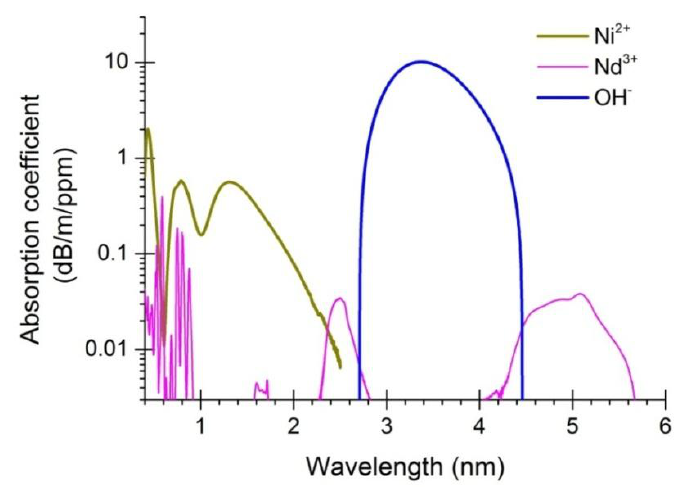
Figure 1. Comparison of absorption coefficients of some selected impurities in a conventional tellurite glass (composition: 75TeO from results in Reference